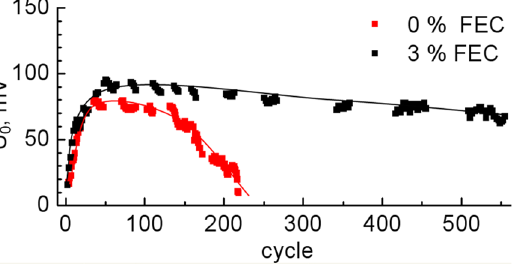
Figure 6. Dependence of the voltage U 0 corresponding to the end point of the lithiation curve at Q ch = 1000 mAh/g.